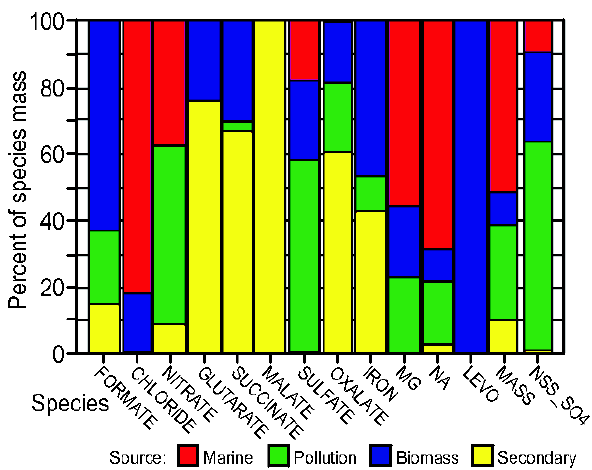
Figure 4. Source profiles for the four sources identified by the PMF model for the CARMA-II (2004) data set.